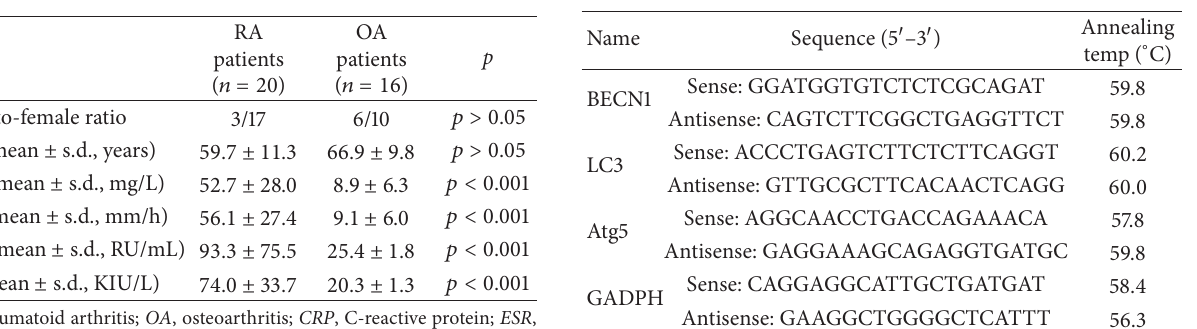
Table 1: Clinical data for RA and OA patients. Table 2: Primers used for real-time